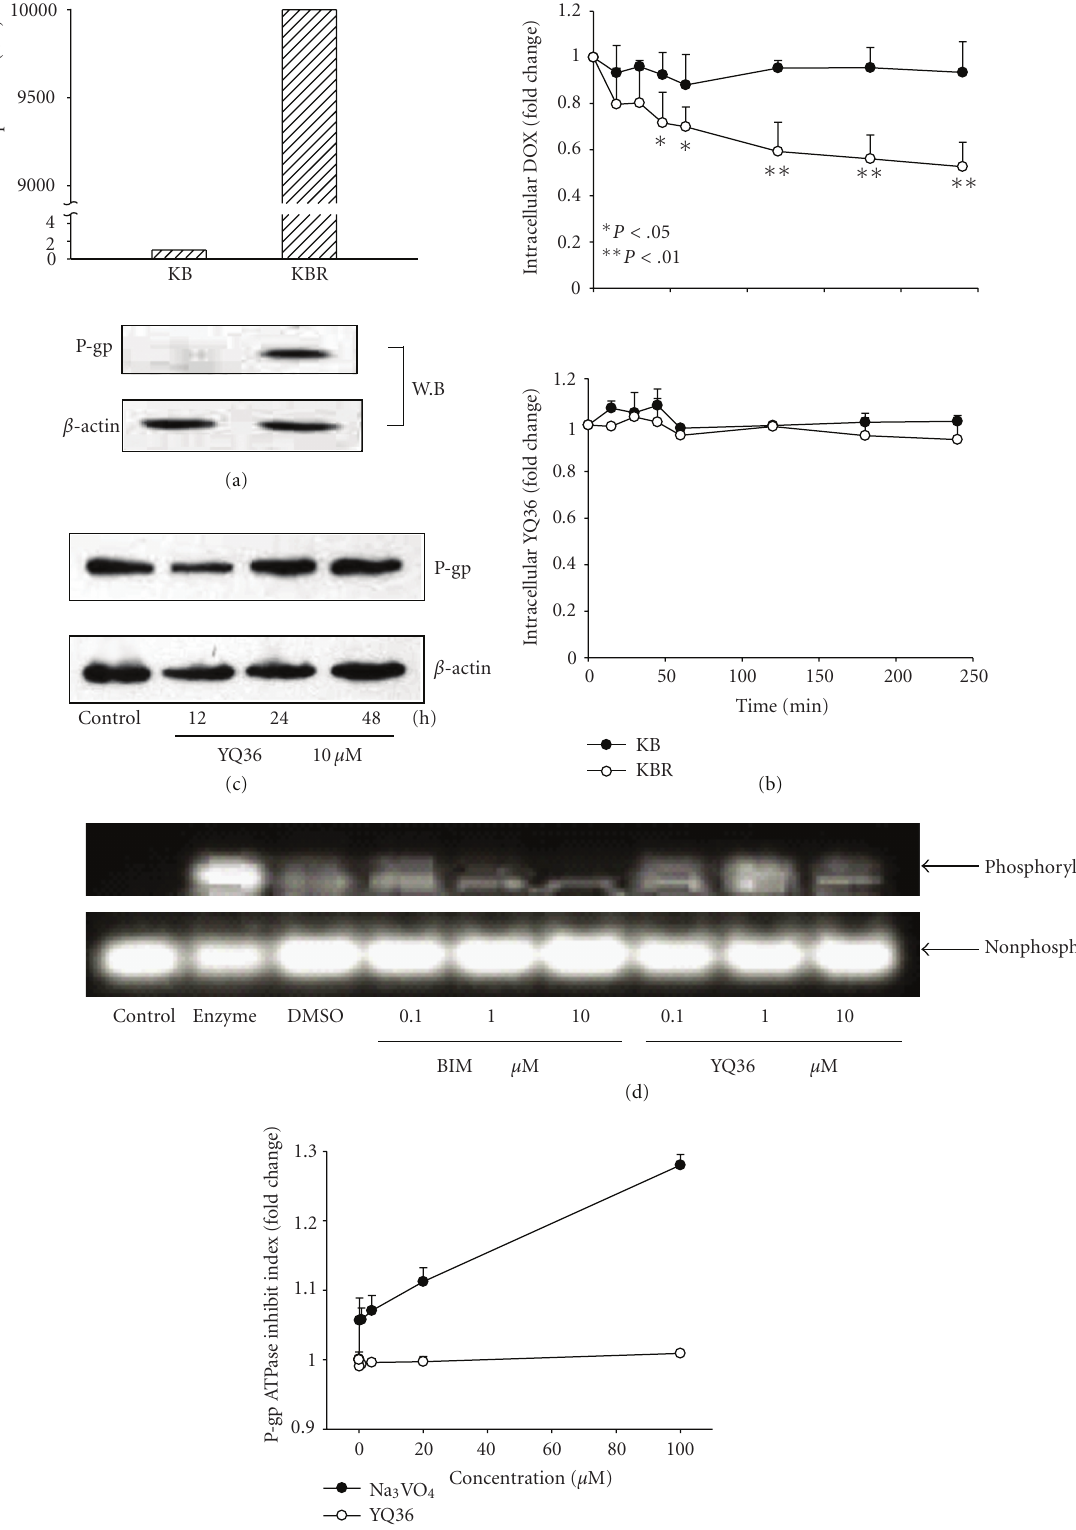
Figure 3: The action of YQ36-induced antimultidrug-resistance on KB/VCR